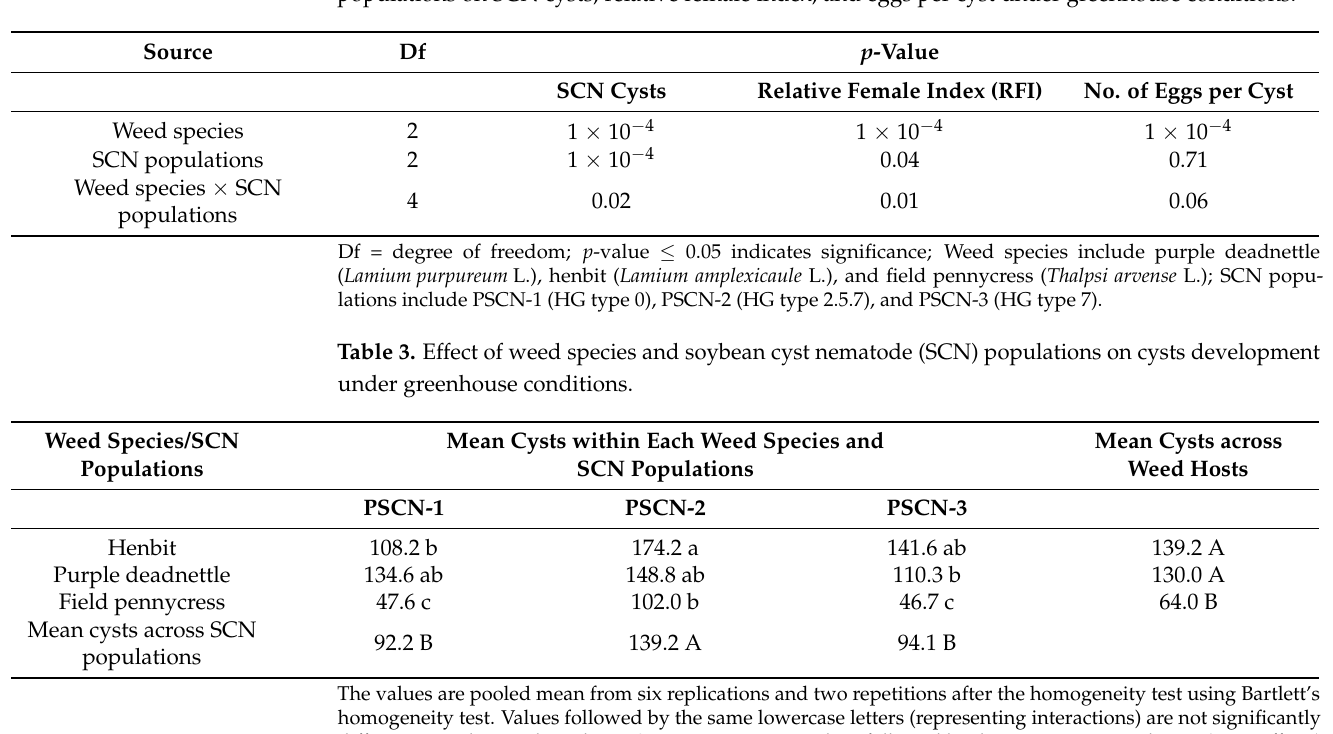
Table 2. Analysis of variance of the effect of weed species and soybean cyst nematode (SCN) populations on SCN cysts, relative female index, and eggs per cyst under greenhouse conditions.